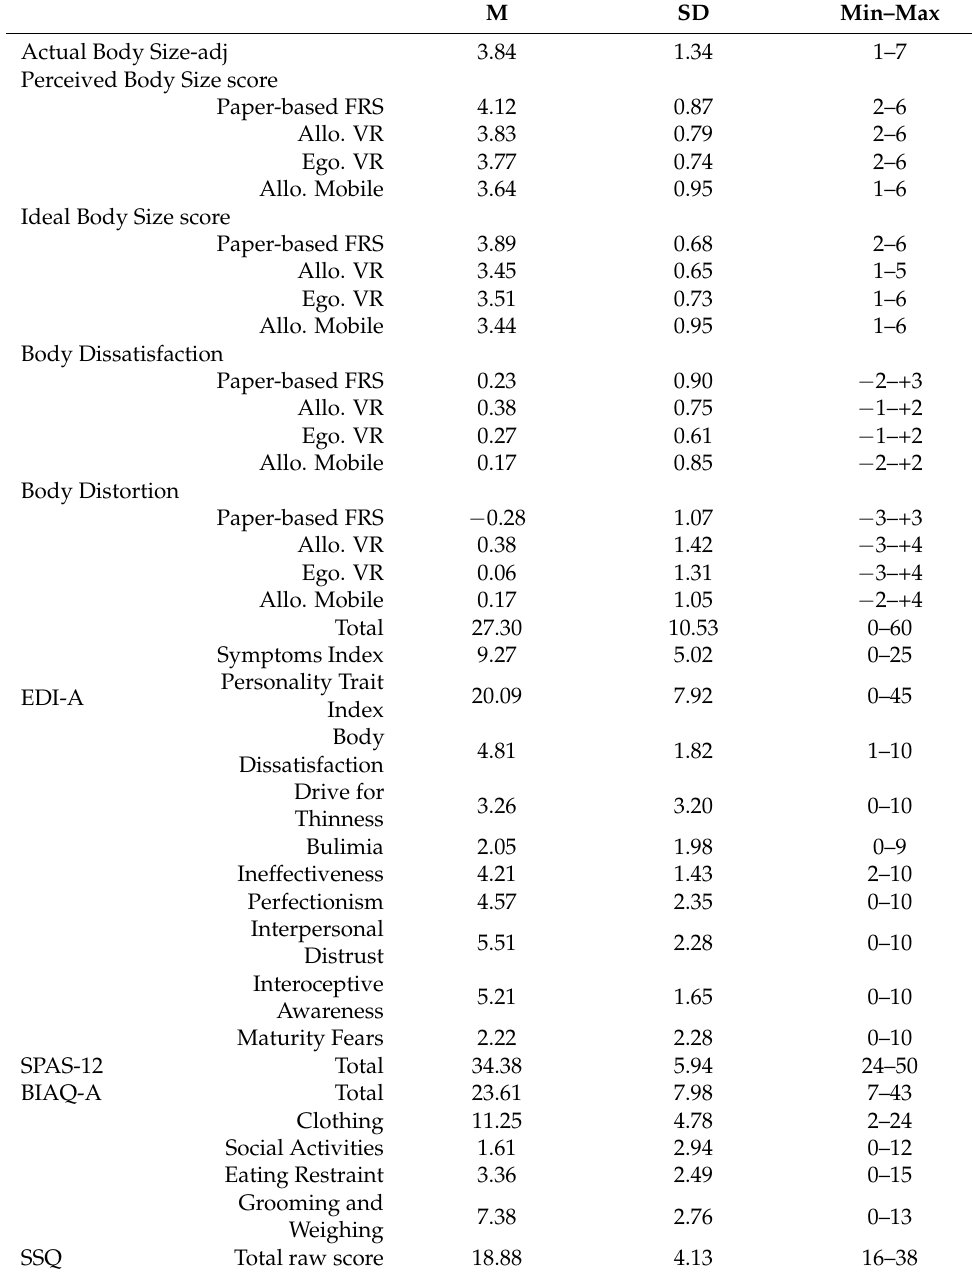
Table 1. Descriptive